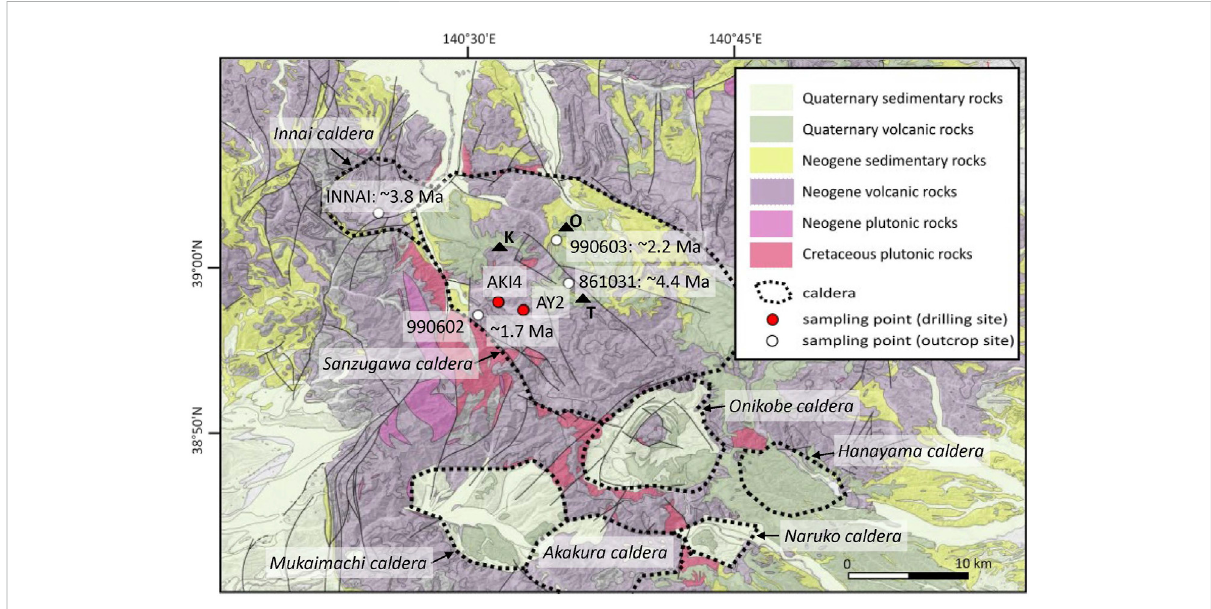
FIGURE 2 GeologicalmapinandaroundtheSanzugawacalderamodi fi edfromSeamlessdigitalgeologicalmapofJapan1:200,000(GeologicalSurveyof Japan, AIST). Sample names and zircon U-Pb ages are shown. Black triangles are Quaternary volcanoes (O: Mt. Okumiya, K: Mt. Kobinai, T: Mt.